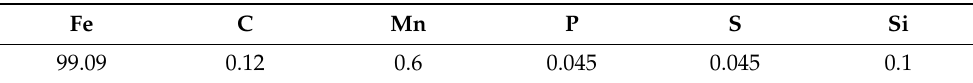
Table 2. Chemical composition of the EN10130 carbon steel